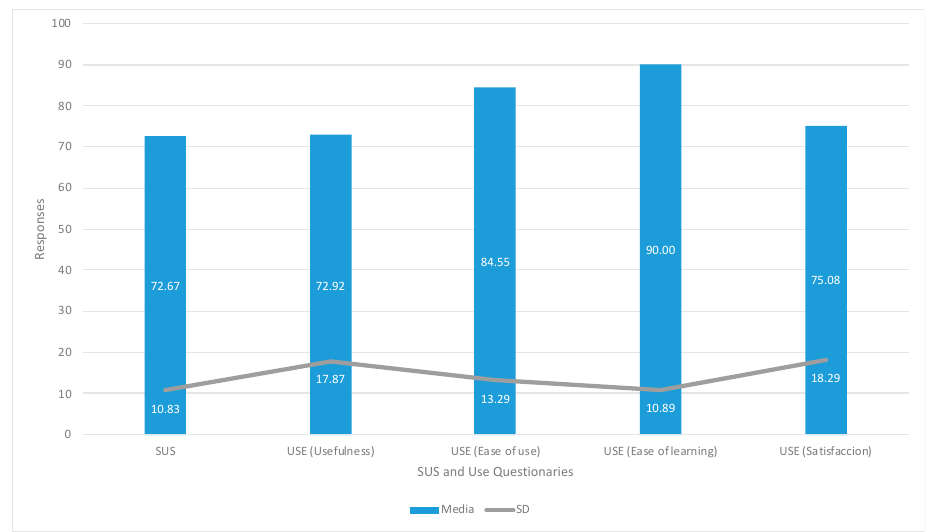
Figure 9. Relation of SUS and USE questionnaires.